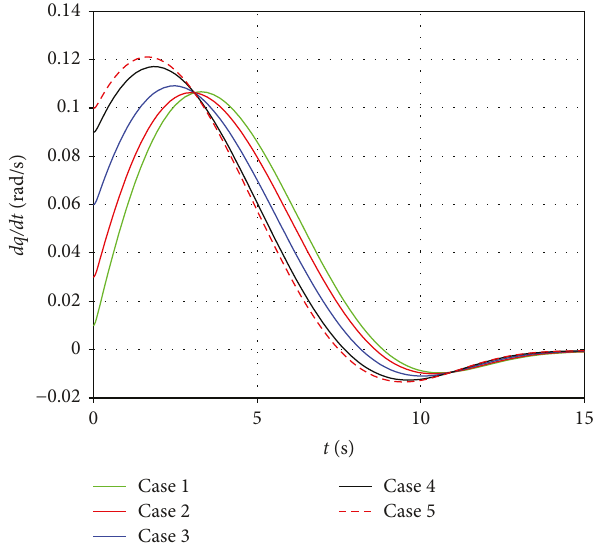
Figure 22: LOS angle rotation rate variation of Defender 1.